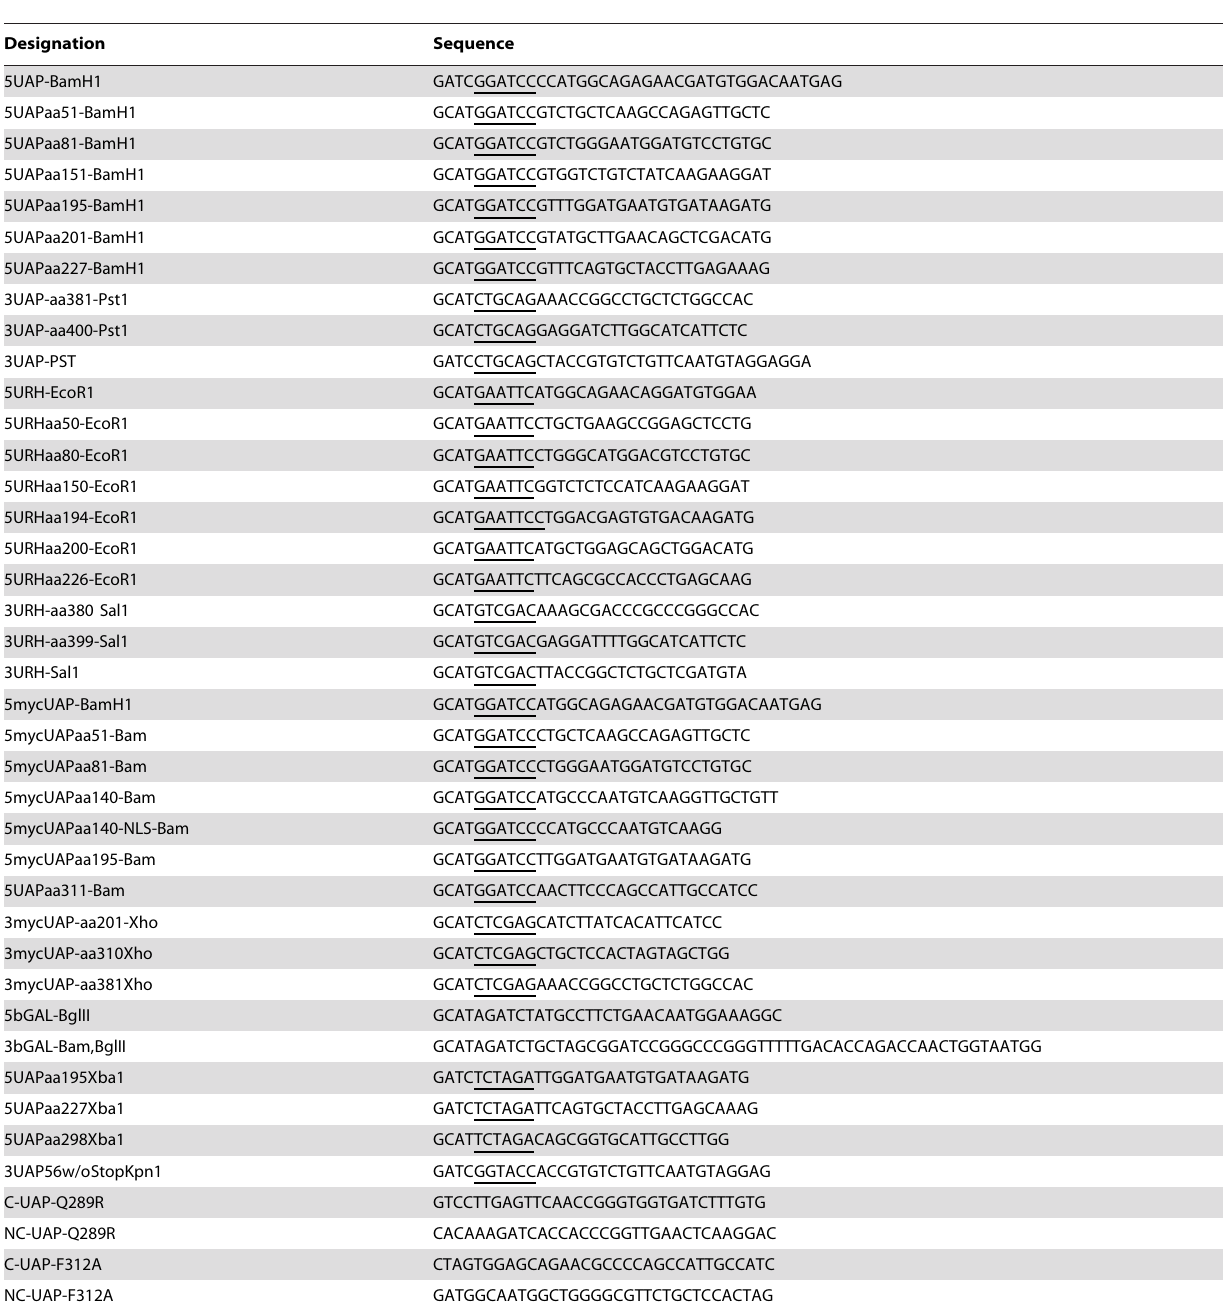
Table 1. Oligonucleotides that were used in this study; restriction sites are